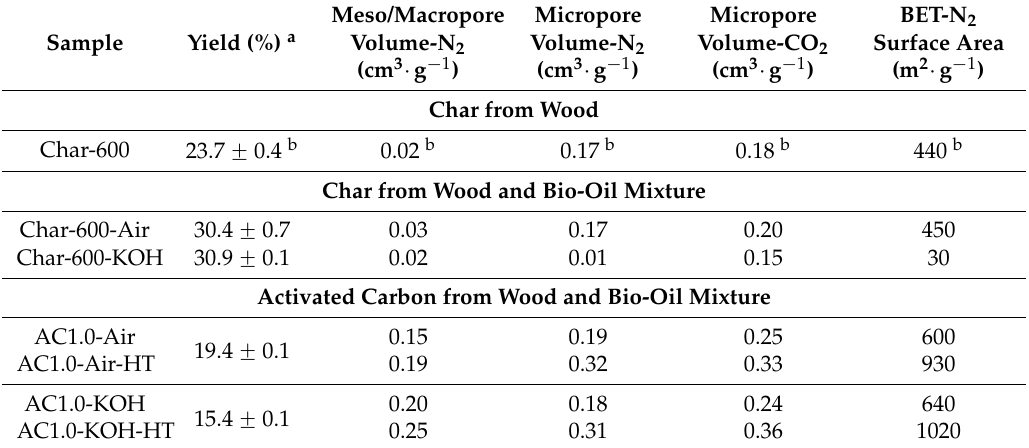
Table 2. Yield and porous properties of carbon produced from wood and bio-oil mixture.